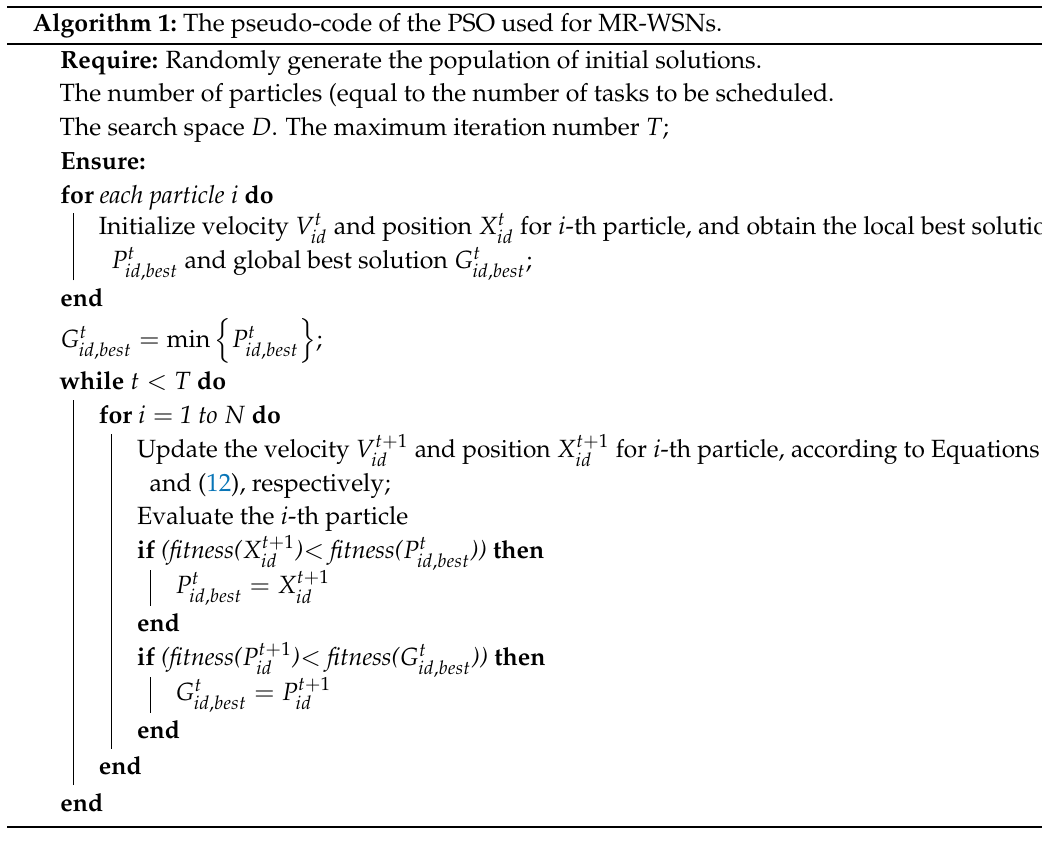
Algorithm 1: The pseudo-code of the PSO used for MR-WSNs.